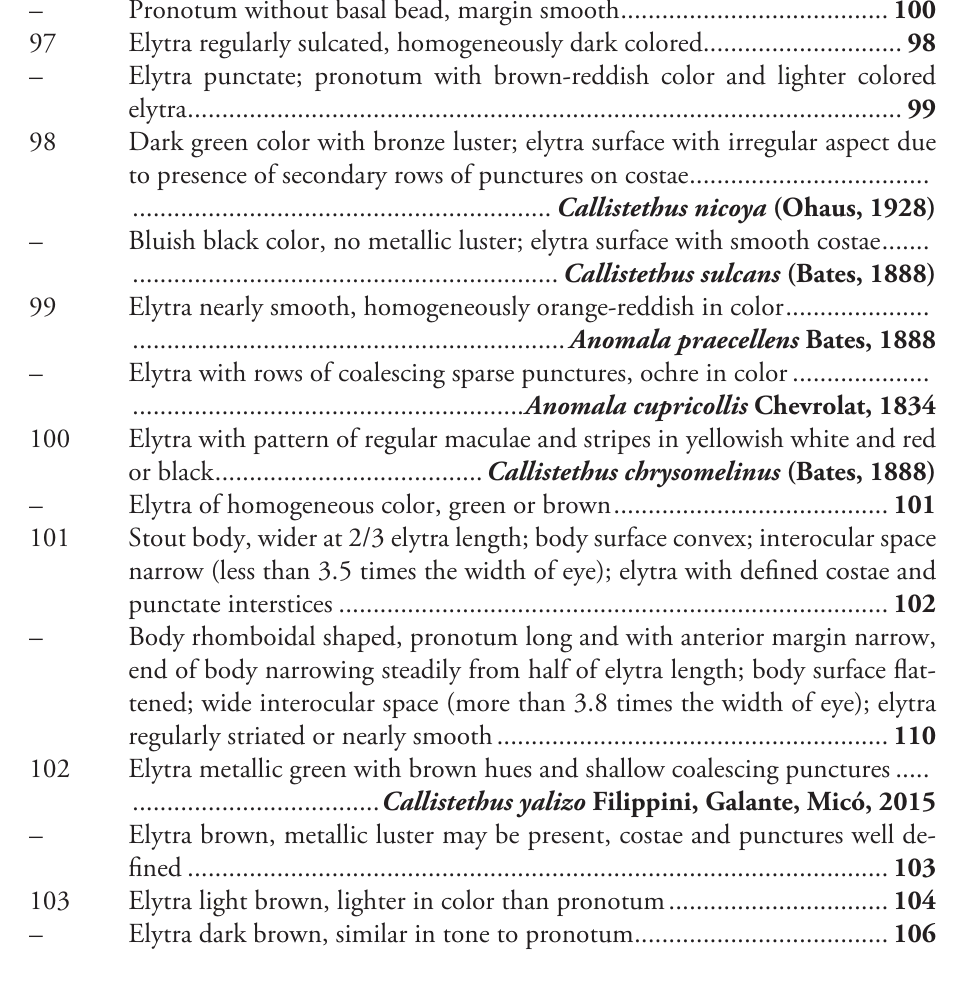
– 93 Elytra with branched yellow lines at apex; pronotum entirely metallic green – 94 Elytra black with ochre base .... Anomala mersa Filippini, Galante, Micó, 2015 – 95 Pronotum with two dark maculae; elytra with black maculae on humeral – Pronotum entirely black; elytra with irregular black maculae mainly on 96 Pronotum with basal bead, complete or obliterated at the middle ............ 97 – 97 – Elytra punctate; pronotum with brown-reddish color and lighter colored 98 Dark green color with bronze luster; elytra surface with irregular aspect due to presence of secondary rows of punctures on costae ................................... – Bluish black color, no metallic luster; elytra surface with smooth costae ....... 99 – Elytra with rows of coalescing sparse punctures, ochre in color .................... 100 Elytra with pattern of regular maculae and stripes in yellowish white and red – 101 Stout body, wider at 2/3 elytra length; body surface convex; interocular space narrow (less than 3.5 times the width of eye); elytra with defined costae and – Body rhomboidal shaped, pronotum long and with anterior margin narrow, end of body narrowing steadily from half of elytra length; body surface flat- tened; wide interocular space (more than 3.8 times the width of eye); elytra 102 Elytra metallic green with brown hues and shallow coalescing punctures ..... – Elytra brown, metallic luster may be present, costae and punctures well de- 103 Elytra light brown, lighter in color than pronotum ................................ 104